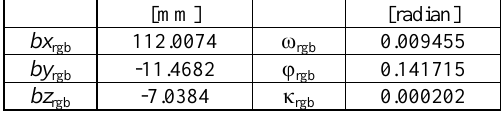
Table 4: Relative orientation parameters for RGB camera